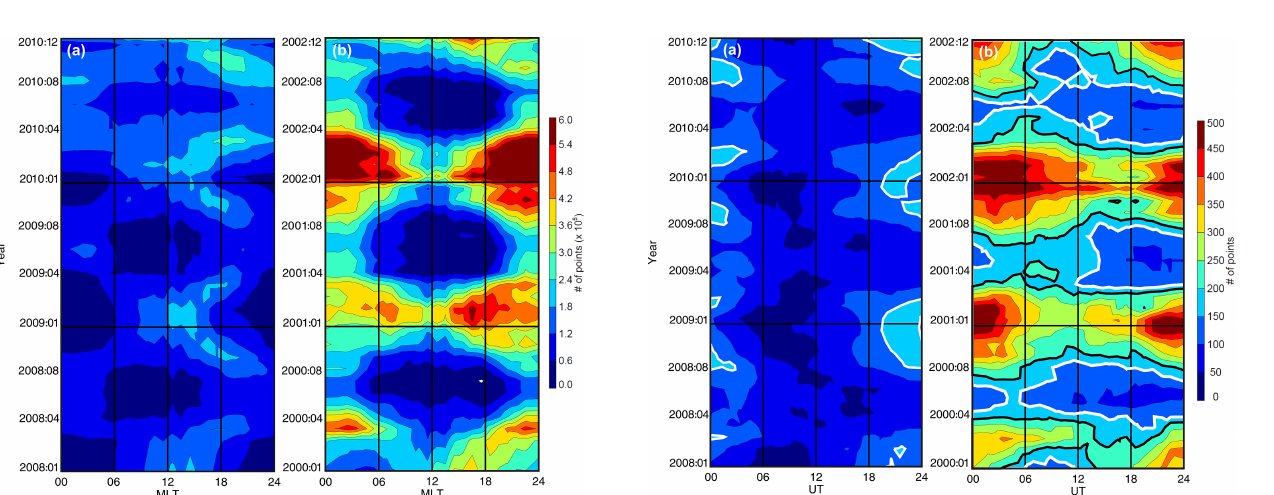
Fig. 6. Contour plot for the total number of grid points on Super- DARN convection maps (cumulative over all magnetic latitudes of echo detection) for observations in the periods of (a) minimum solar activity (2008–2010) and (b) maximum solar activity (2000–2002) as a function of MLT time.